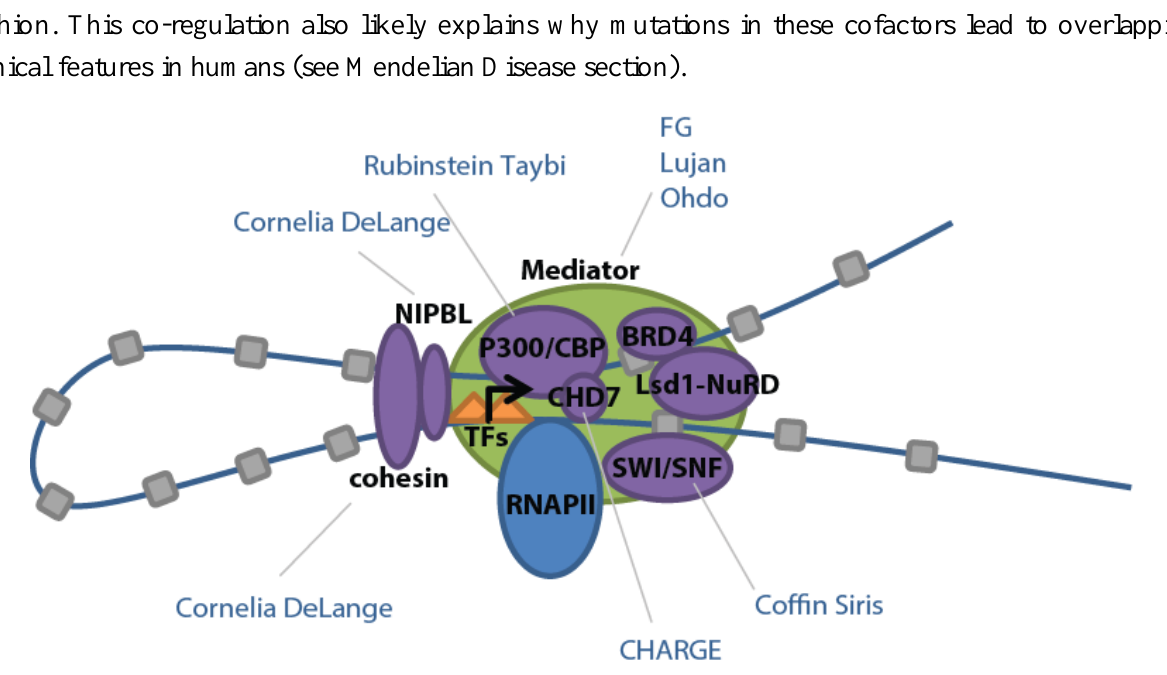
Figure 3. Schematic of transcriptional factors found in ESC super-enhancers and their related developmental diseases. Adapted from [10] with